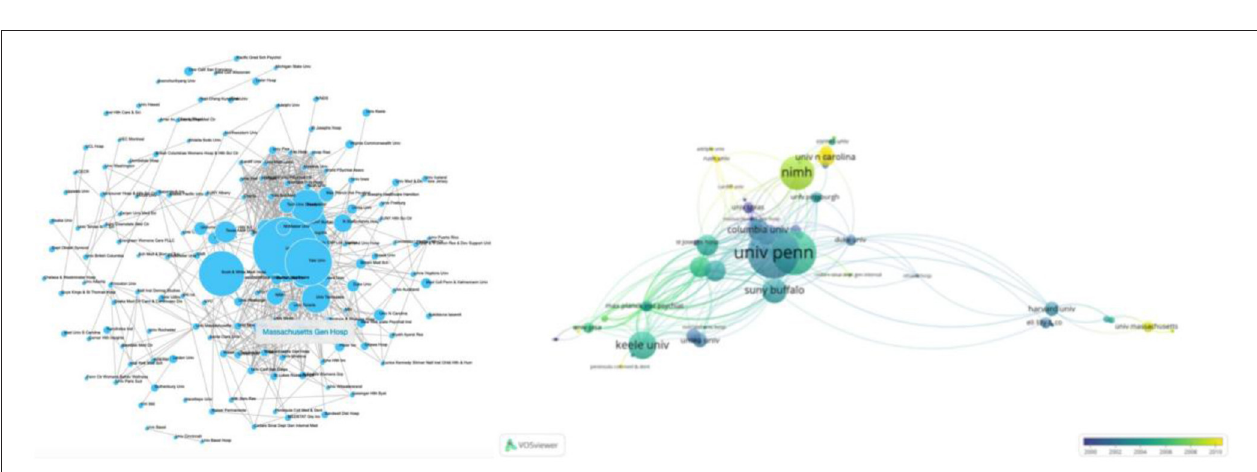
FIGURE 5 | Networks showing the collaboration among countries/regions in the top 100 cited papers. Circle size represents the number of papers in the top 100 cited articles.